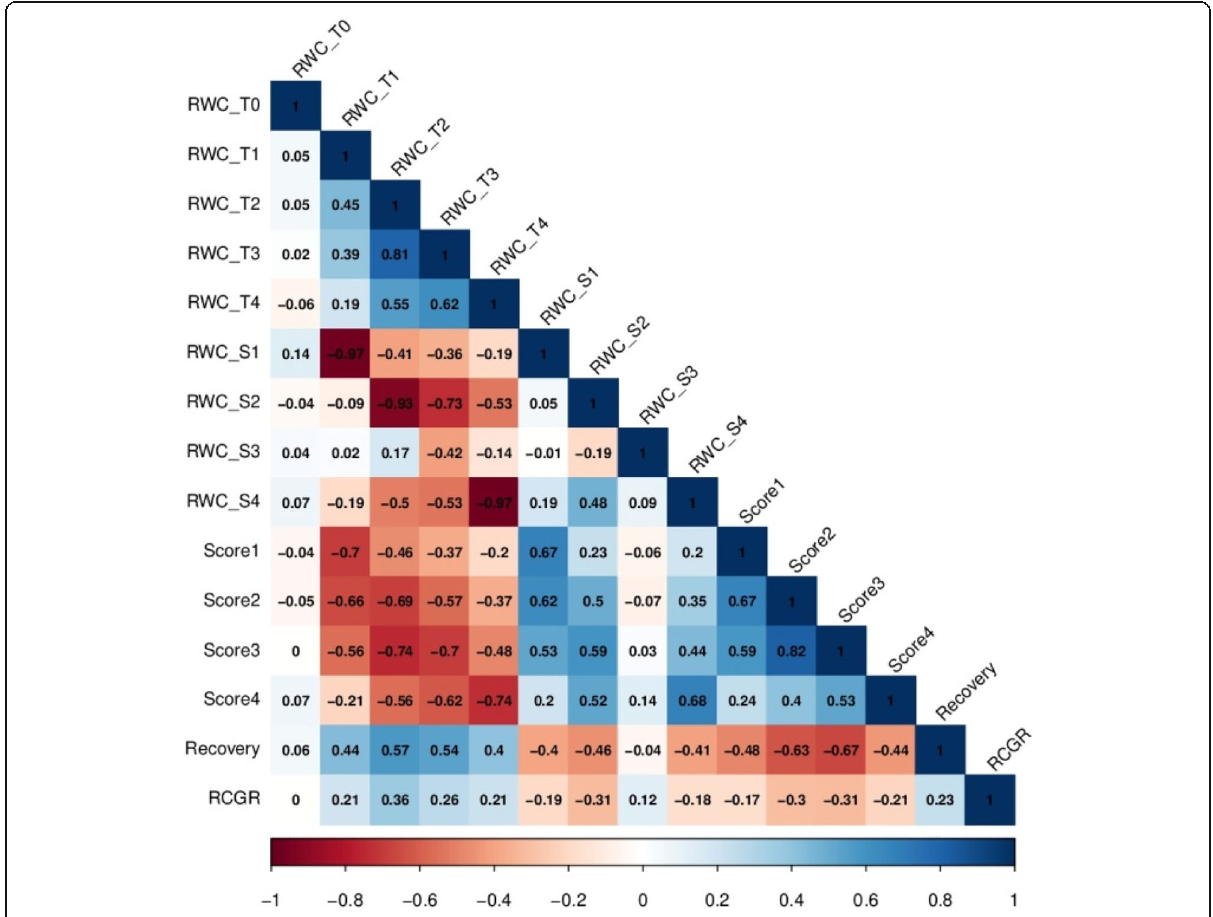
Fig. 3 Correlations between traits in the full panel. RWC_T0, relative water content before drought treatment; RWC_T1 to RWC_T4, relative water content after 1 to 4 weeks of drought stress; RWC_S1 to RWC_S4, slope of relative water content after 1 to 4 weeks of drought stress; Score1 to Score4, drought sensitivity score after 1 to 4 weeks of drought stress; Recovery, recovery ability; RCGR, relative crop growth